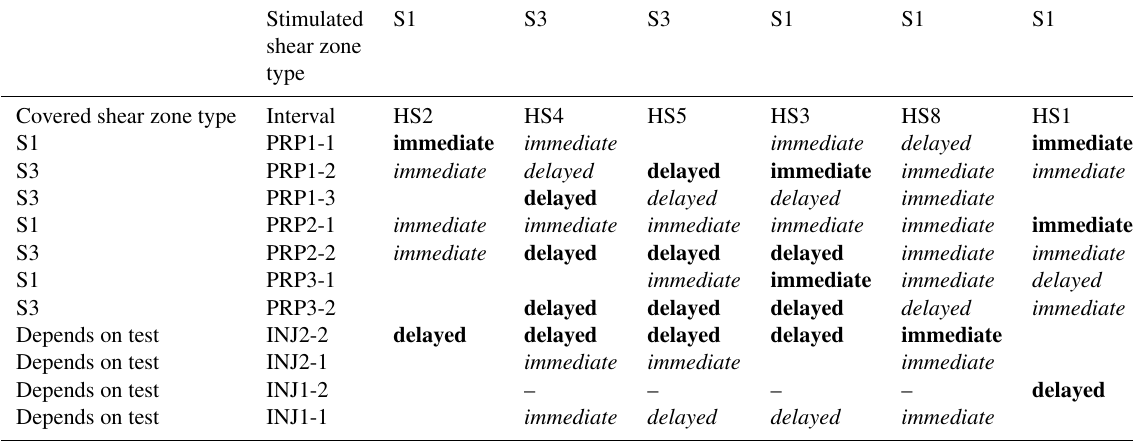
Table A3. Response behavior of the pressure monitoring intervals at shut-in of injection cycle 3 for all HS tests. This table also makes the link to the shear zone targeted during each stimulation and covered by the monitoring intervals. The responses are classified as immediate (in the case of an immediate response to shut-in) and delayed (in the case of a delayed response to shut-in). The bold responses are from the intervals that covered the exact targeted shear zones. The ones in italics are taken from the intervals that do not cover the targeted shear